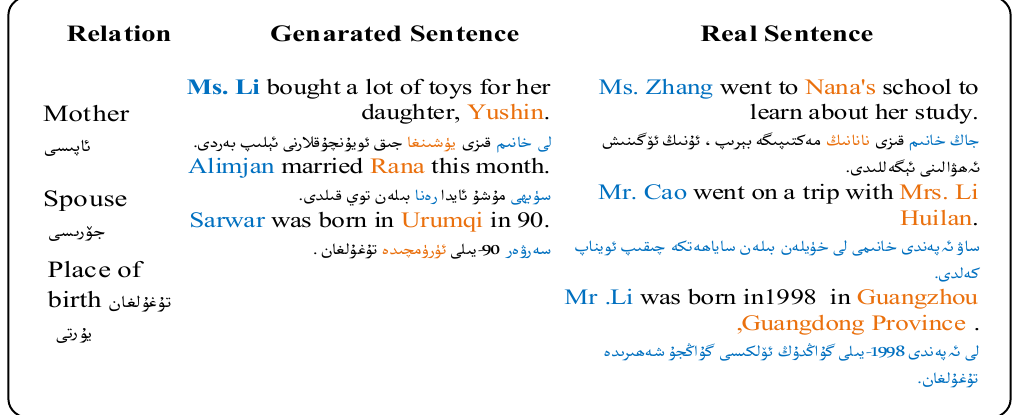
Figure 3. Comparison of real and generated data.